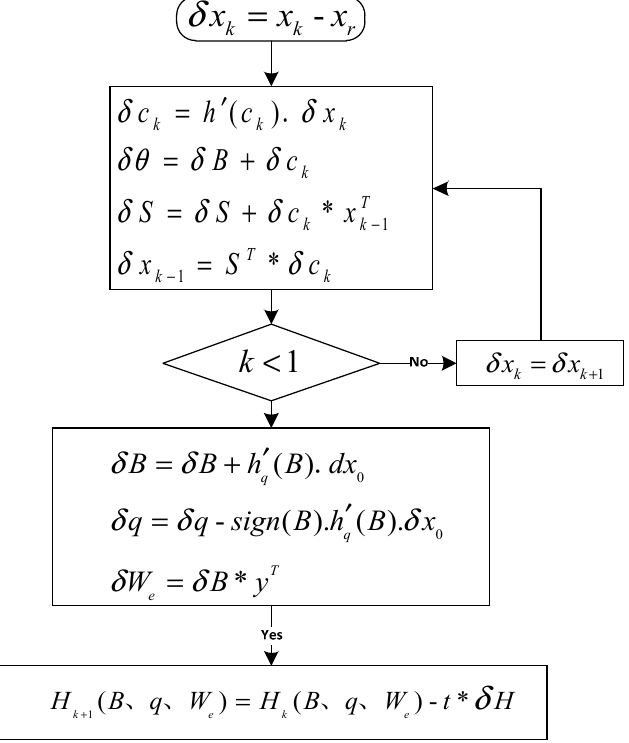
Figure 5. Flowchart of the backward error correction algorithm.